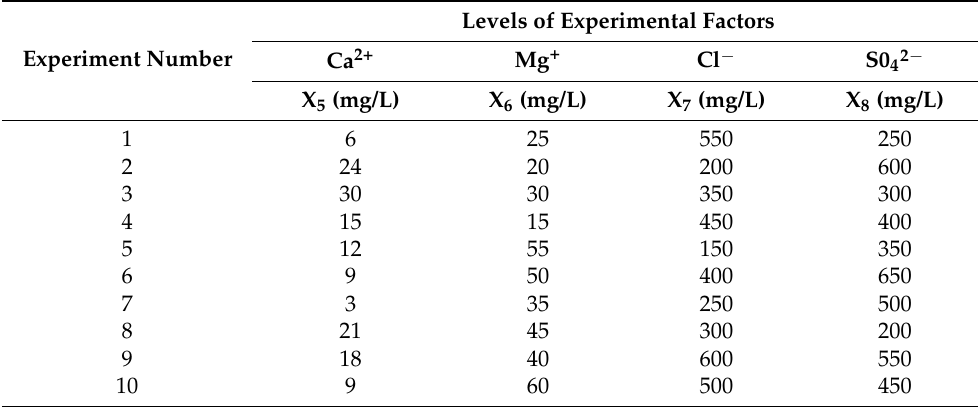
Table 3. Experimental factors (Ca 2+ , Mg + , Cl − , and S0 42 − ions) and established levels.